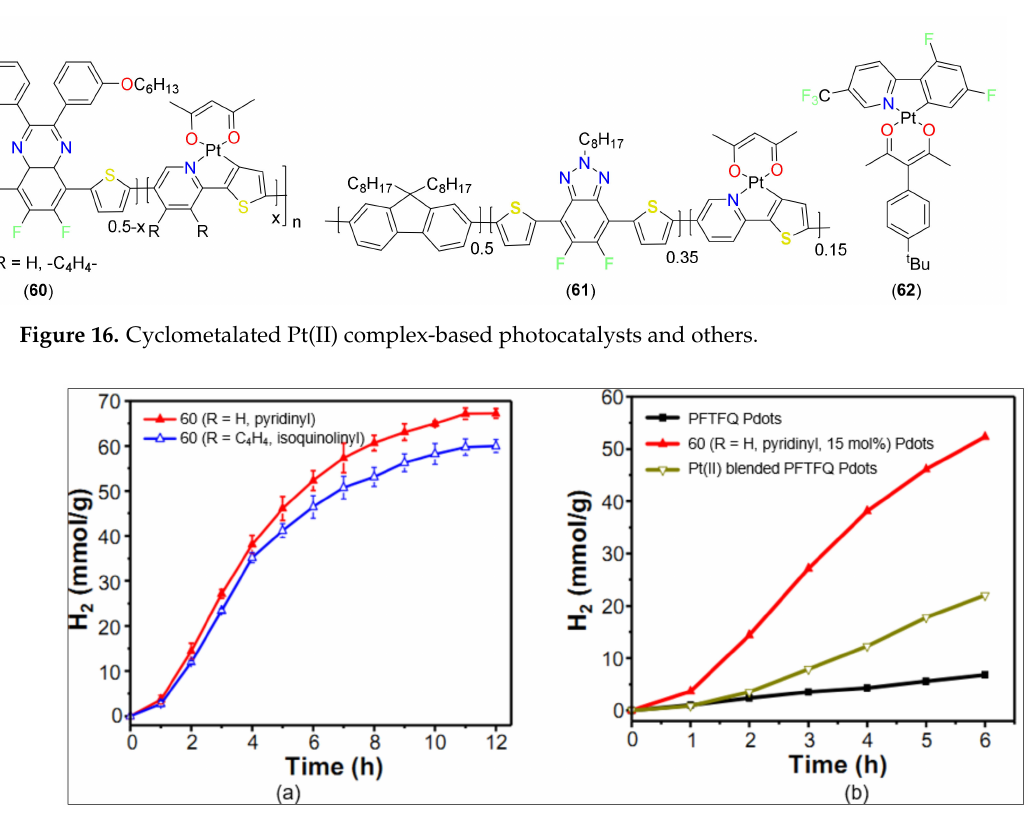
Figure 17. ( a ) Time course of produced H 2 for 60 (15 mol%) Pdots for 12 h. ( b ) Comparison of hydrogen generation of chemically linked 60 Pdots and physically Pt(II)-blended-counterpart PFTFQ Pdots. Reproduced with permission from ref.